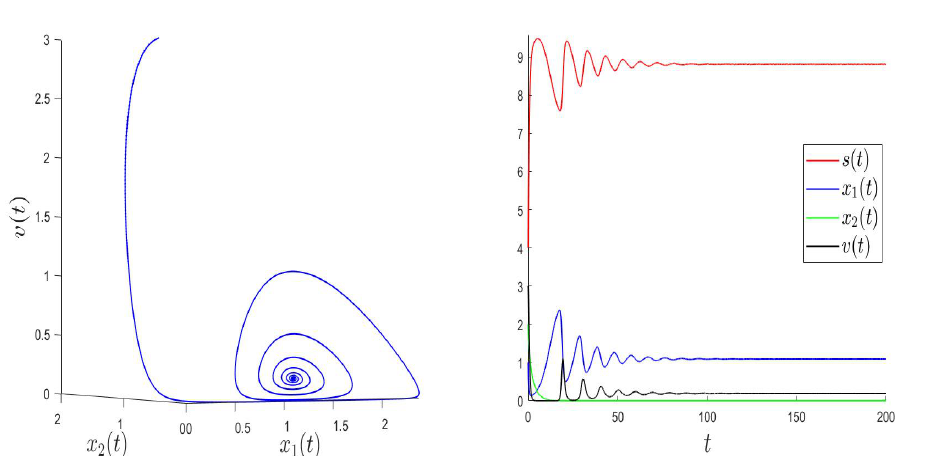
Figure 6. D = 2.1875, D 1 = 2.5, D 2 = 1.875, D 3 = 2.85, D 4 = 1.640625, D 5 = 1.96, D 6 = 5.5172, ¯ s 1 = 7.24138, ¯ s = 11.3066. Assumption 1 is not satisfied, and the solution of the system (2) converges to the equilibrium E 1 , where only species 1 persists with the 1